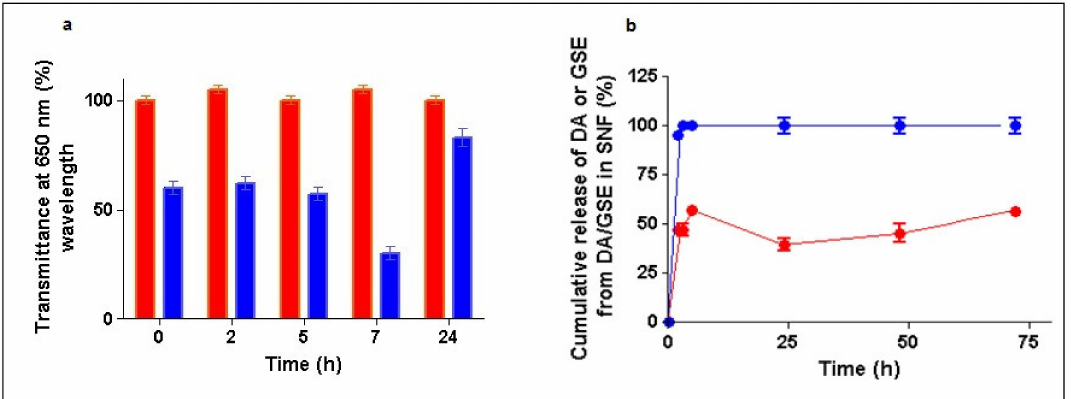
Figure 5. Panel ( a ): Mucoadhesive properties in simulated nasal fluid (SNF) of GSE/DA-SLN (blue bars) with hydrox- yethylcellulose (HEC) (red bars) taken as positive control. Panel ( b ): In vitro release of dopamine (red line) and grape seed extract (GSE) (blue line) from GSE/DA-SLN in SNF in the presence of esterases at 37 ◦